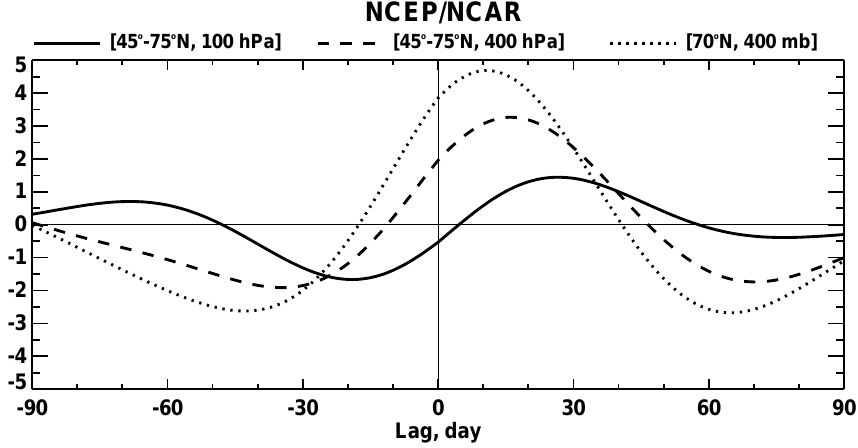
Fig. 8. Lagged regression of the 60-day low-passed normalized NAM index at 20hPa on the 60-day low-passed vertical EP flux anomalies taken at (solid) 100hPa over 45 ◦ –75 ◦ N, (dotted) 400hPa over 45 ◦ –75 ◦ N and, (dashed) at 400hPa, 70 ◦ N. Units are 10 4 kgm − 1 s − 2 . The NCEP-NCAR